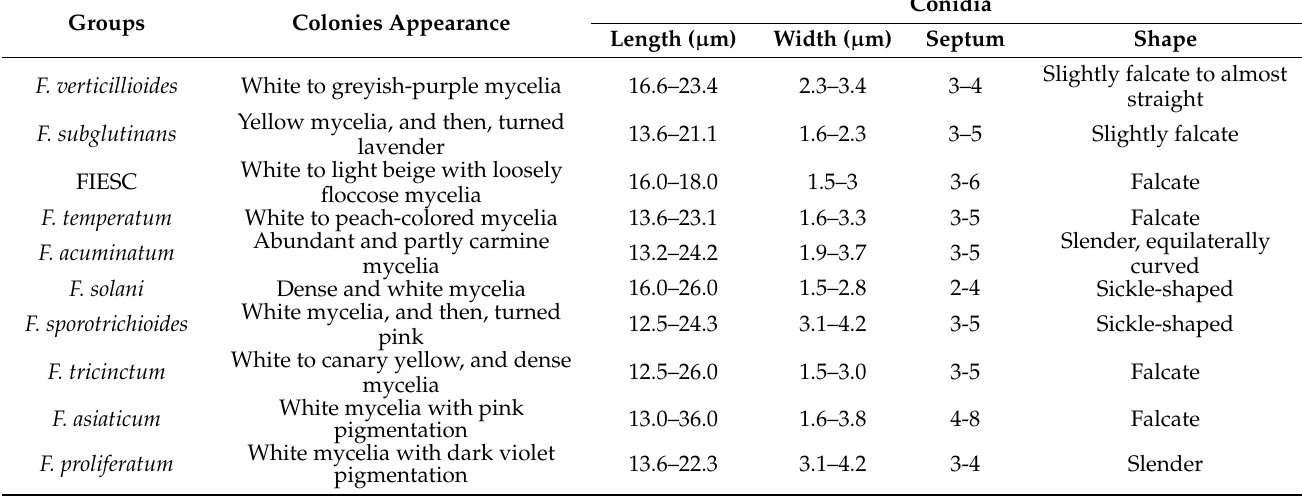
Table 1. The morphological characteristics of Fusarium species obtained in this study.